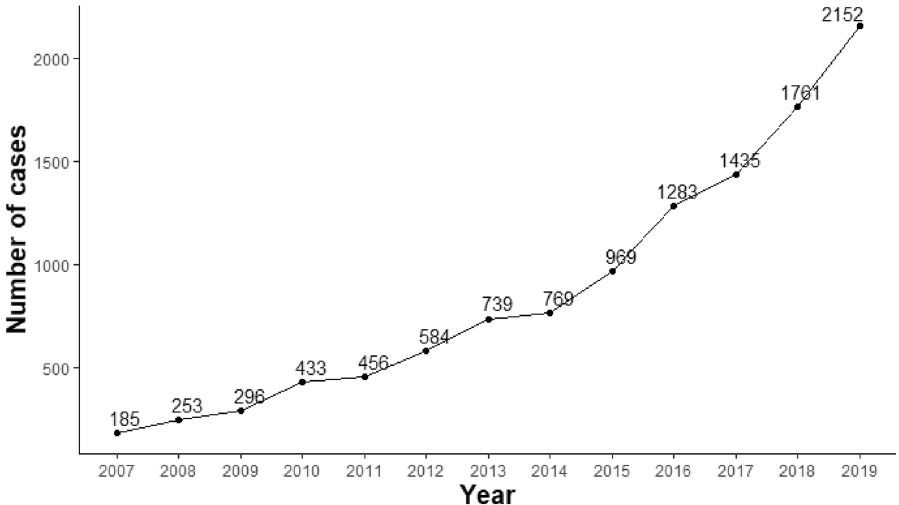
Figure 1. The number of patients with MGUS in South Korea according to the year. The data for the number of patients with MGUS in 2007 and 2008 were derived from the HIRA database of this study, and the data after 2009 were derived from the public data provided by HIRA.